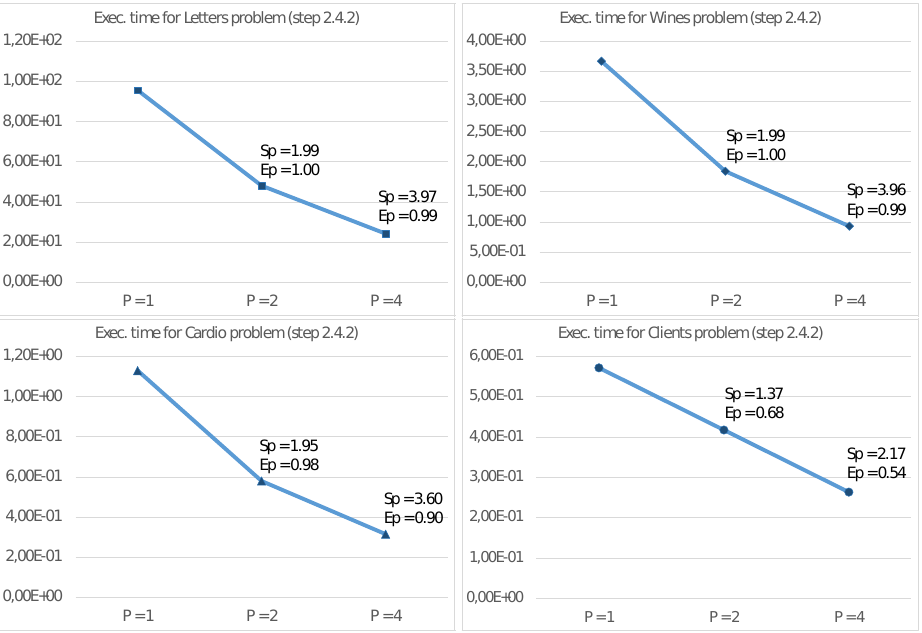
Figure 5. Execution time (in seconds), Speed-up and Efficiency of step 2.4.2 of Algorithm 2 on the UDOO X86 Advanced+